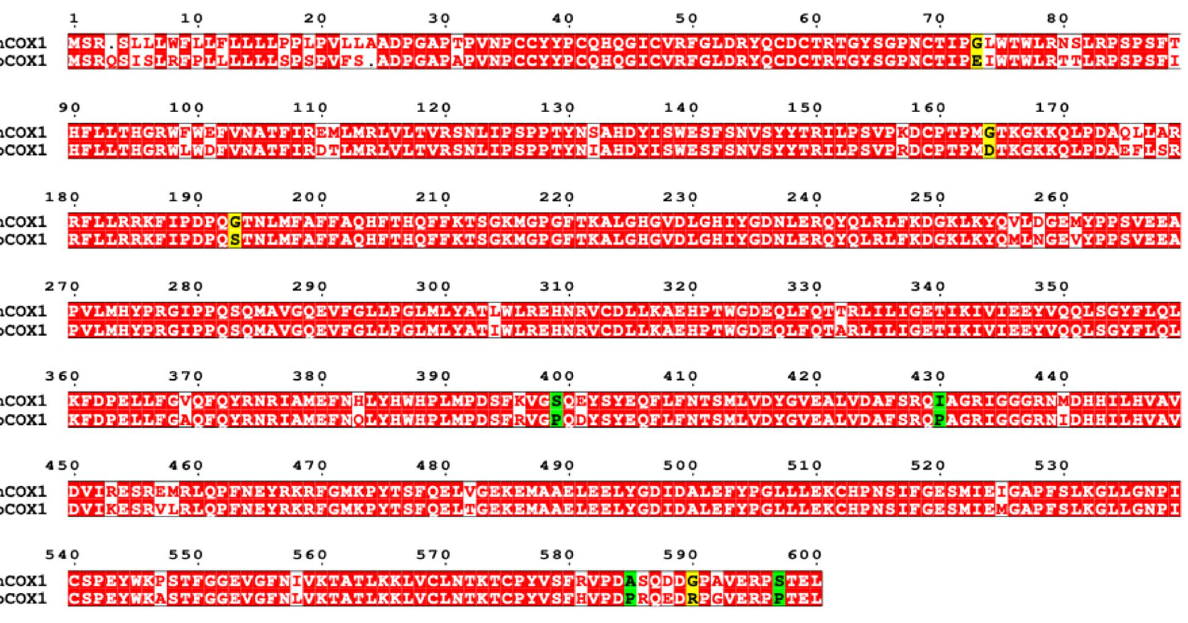
Figure 1. Alignment of human and ovine COX-1. Amino acid sequences of COX-1 from human, h , (NM_000962.4) and ovine, o , (NM_001009476.1) were aligned with the ClustalW program. The alignment was performed at NPS@ Web server of the PBIL using GONNET weight matrix and formatted with ESPript 3.0 21 . The red boxes include identical amino acids in both sequences. Unconserved residues are included in the white boxes. Among these amino acids, the proline residues present only in o COX-1 are shown in the green boxes, while the glycine residues present only in h COX-1 are displayed in the yellow